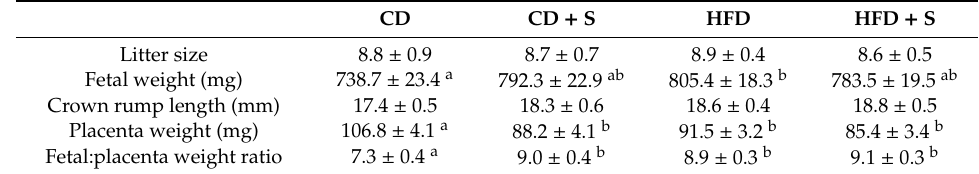
Table 4. The e ff ect of diet and short-term micronutrient supplementation on litter size and fetal